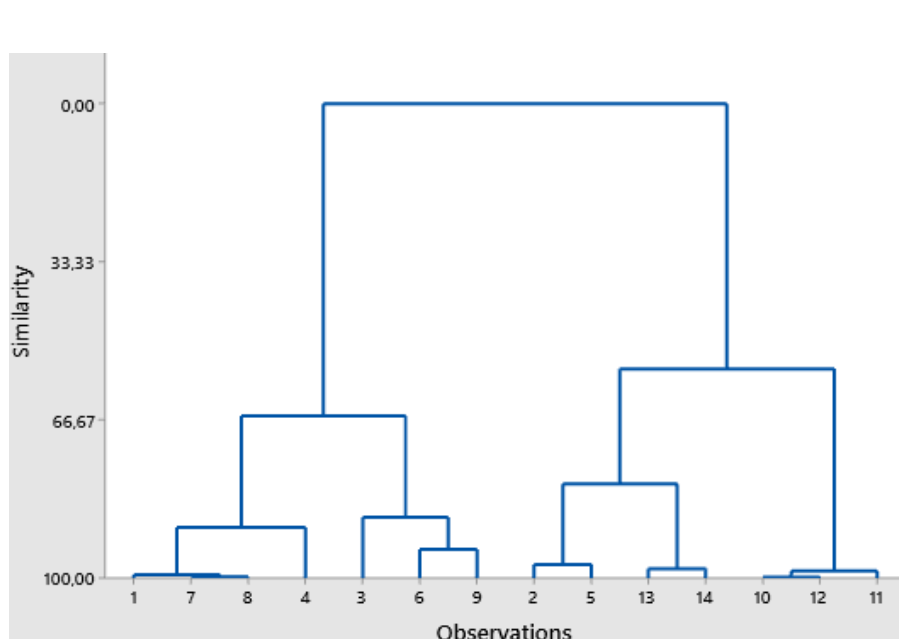
Figure 2. The dendrogram of fish oil samples from different species and extraction methods. 1 = PFO by Maceration (n-hexane, wet samples); 2 = PFO by Maceration-(ethyl acetate, wet samples); 3 = PFO by Maceration (chloroform, wet samples); 4 = PFO by Maceration (n-hexane, dried samples); 5 = PFO by Maceration (ethyl acetate, dried samples); 6 = PFO by Maceration (chloroform, dried samples); 7 = PFO by Soxhlet (n-hexane, dried samples); 8 = PFO by Soxhlet (chloroform, dried samples); 9 = PFO by UAE (n-hexane:isopropanol, dried samples); 10 = PFO by Pressing-(dried samples); 11 = POO by Pressing (dried samples); 12 = BHO by Pressing- (dried samples); 13 = GHO by Pressing (dried samples); 14 = GOO by Pressing (dried samples). PFO = Patin flesh oil; BHO = Bandeng head oil; GHO = Gabus head oil; GOO = Gabus offal